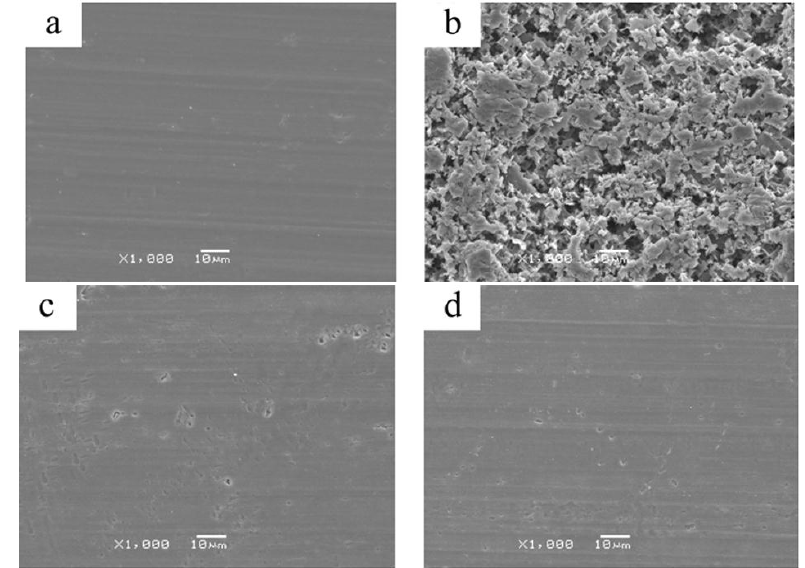
Figure 6. SEM images of AA5052 surface before and after immersing in 1 M HCl for 2 h without and with triazinedithiol inhibitors. ( a ) Blank before immersion; ( b ) blank after immersion; ( c ) with DAN; ( d ) with DBN.